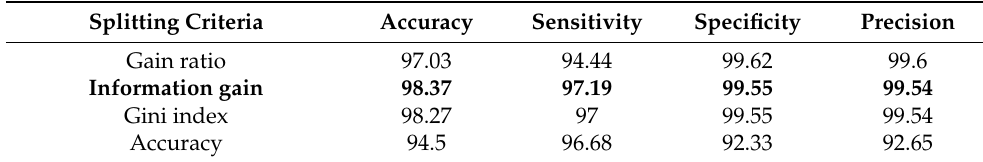
Table 6. The best splitting criteria for the random forest.